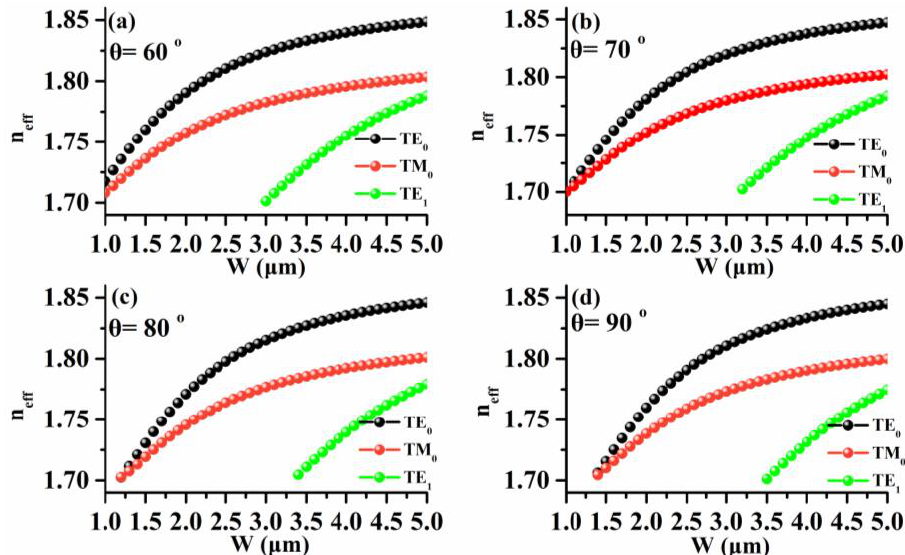
Figure 4. Effective refractive indices n eff of the TE 00 , TM 00 and TE 10 modes as a function of rib width W when the inclination angle ( a ) α = 60 ◦ , ( b ) α = 70 ◦ , ( c ) α = 80 ◦ and ( d ) α = 90 ◦ . The other input parameters are H = 1 µ m, h = 0.7 µ m and λ = 3.3 µ